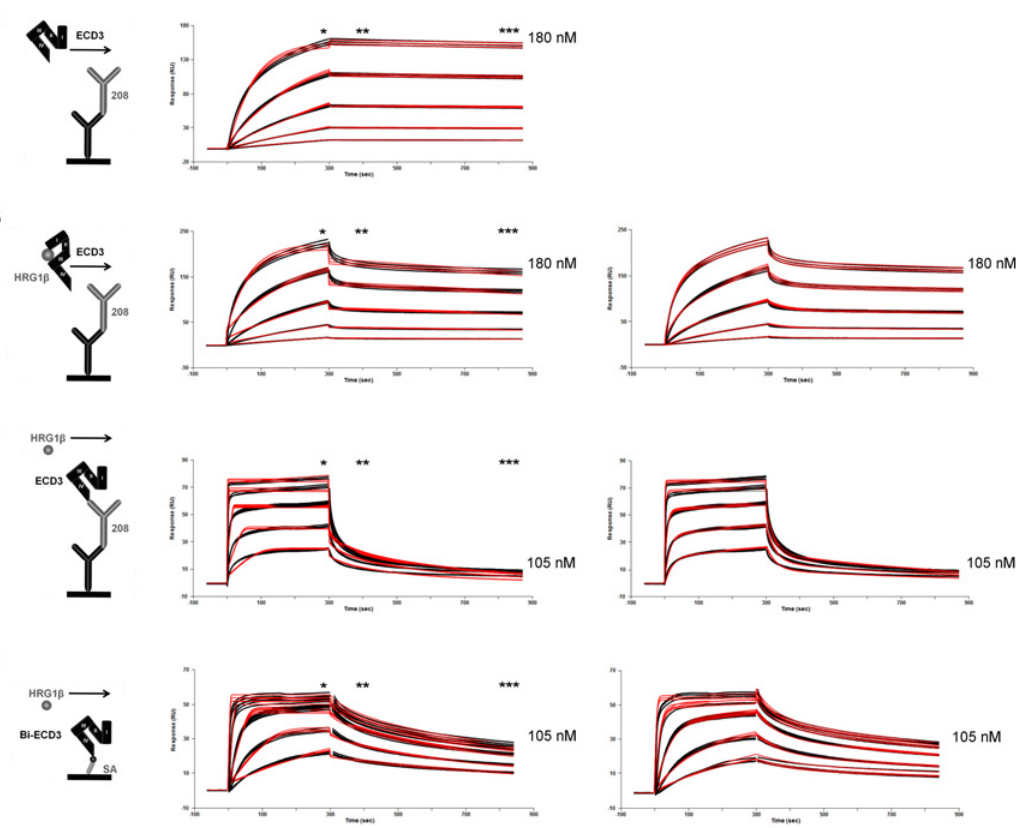
Figure 1. Deciphering the binding behavior of HRG1 β to HER3, investigated by different SPR assay setups. To determine the interaction of HRG1 β with HER3 in presence and absence of anti-HER3 antibody mAb208, four different SPR assay setups were designed. The descriptive symbols illustrate the corresponding assay setups. Arrows indicate injection of analytes (left column). Measured biomolecular interactions were evaluated using a regular Langmuir model (middle column) and where applicable using a two-state reaction model (right column) by Biacore Evaluation Software 2.0. The curve fittings are highlighted in red. The curve corresponding to the highest concentration is indicated in each sensorgram. Report points were used to additionally characterize the shape of the sensorgrams. They are indicated by asterisk: BL early ( * ) is the binding signal shortly before the end of the analyte injection. BL late ( ** ) is the binding signal 100 seconds after the end of the injection. SL ( *** ) is the stability late signal at the end of the dissociation phase. Three replicates of each concentration are shown in black in each sensorgram (n = 3). The third highest concentration of each assay was injected twice (n = 6). (A — C) Murine antibody mAb208 was captured by immobilized rabbit anti-mouse antibody on CM5 sensor chip surface. (A) Injection of HER3 (ECD3). (B) Injection of pre-incubated HER3/HRG1 β . (C) Injection of HRG1 β . (D) Biotinylated HER3-Avi (bi-ECD3) was captured on a streptavidin-coated CAP sensor chip. Subsequently, HRG1 β was